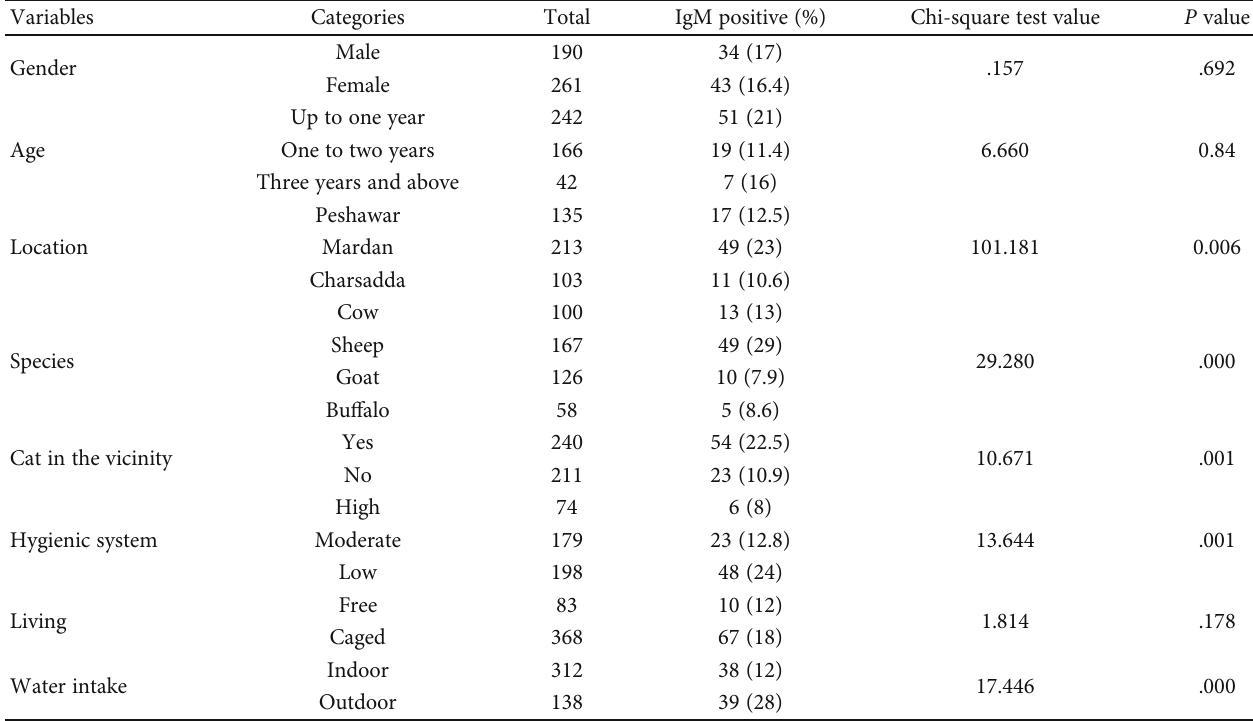
Table 2: Possible risk factors associated with higher IgM antibody of Toxoplasma gondii prevalence in Ruminants using chi-square analysis. Variables